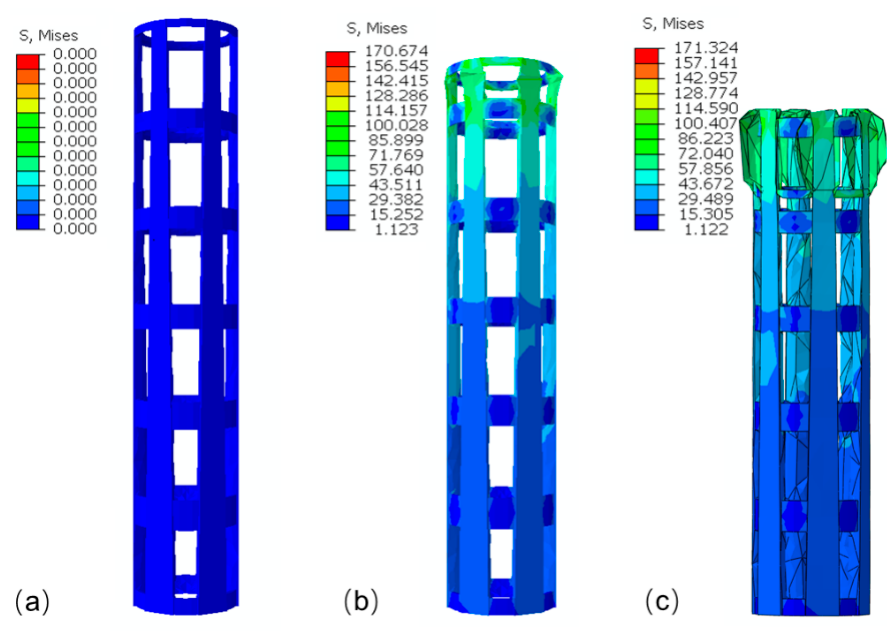
Figure 9. Evolution of deformation behavior of the bamboo FGM lattice structures predicted by FEA: ( a ) ε =0, ( b ) ε =0.07, ( c ) ε =0.15.